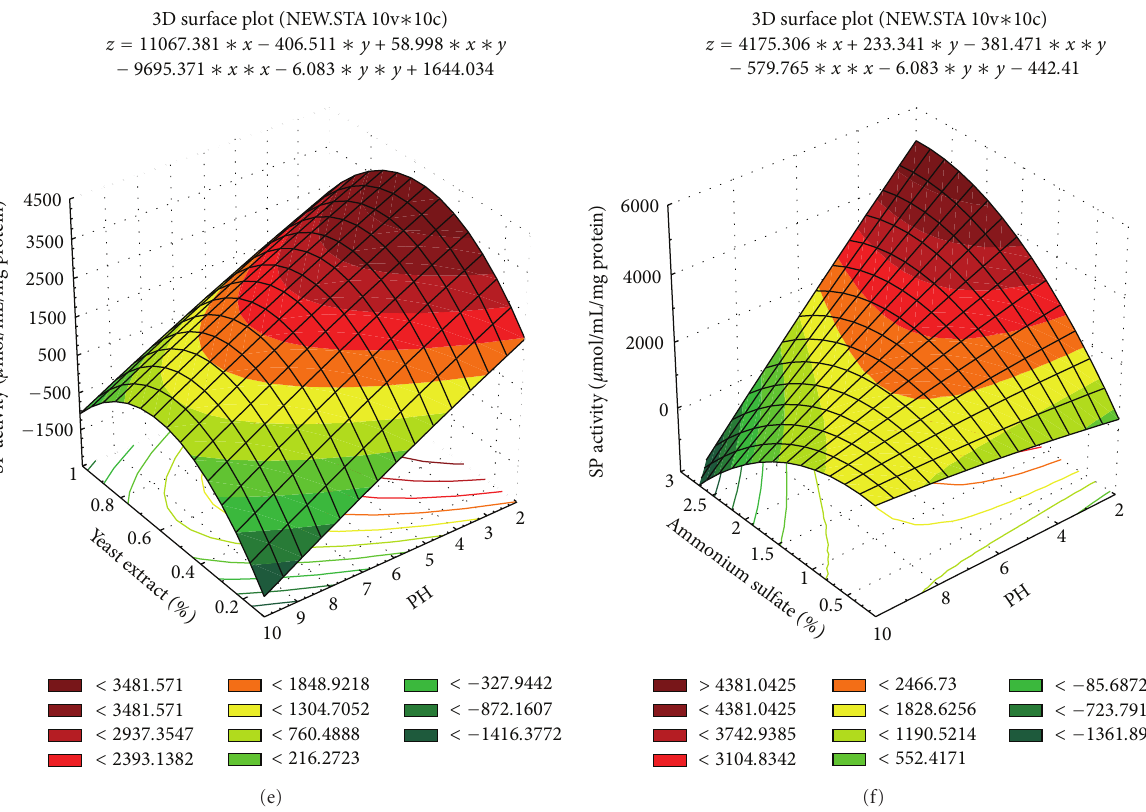
3D surface plot (NEW.STA10v ∗ 10c) z = 11067 . 381 ∗ x − 406 . 511 ∗ y + 58 . 998 ∗ x ∗ y